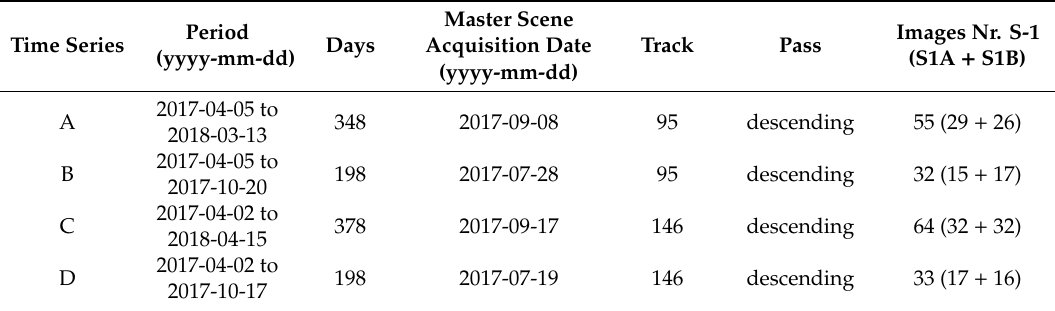
Table 1. Analyzed